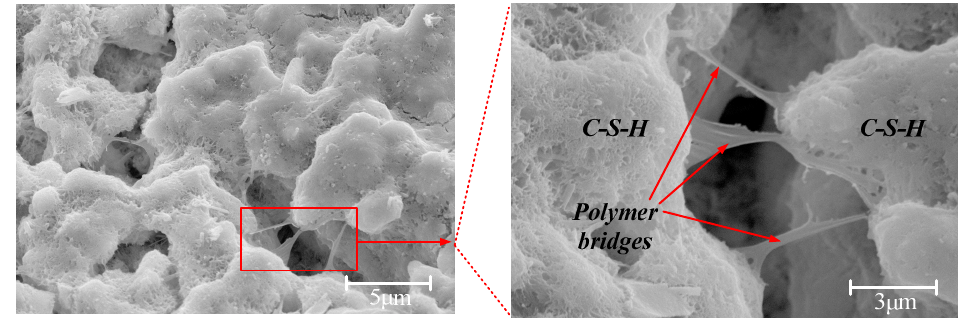
Figure 10. Fourier transform infrared spectroscopy ( FTIR) analysis of cement mortar with different PVA content.